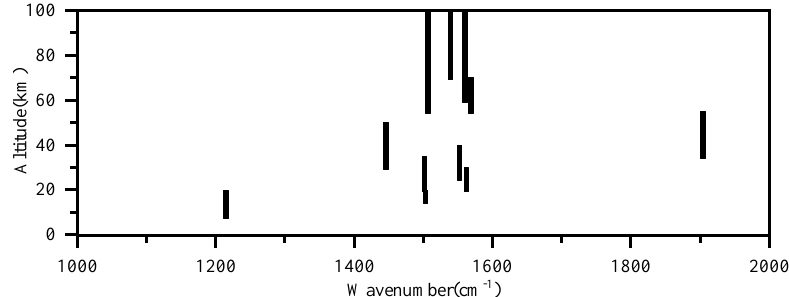
Figure 7. The selected micro-windows for H 2 O retrieval.